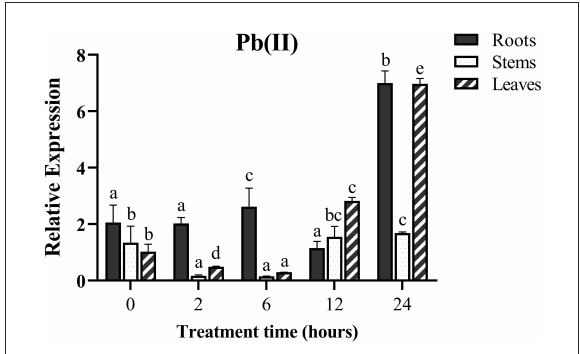
FIGURE2 Expression of MePMEI1 under Pb stress. The 45-days-old SC8 cassava seedlings were treated with 1mM Pb(NO 3 ) 2 for 0, 2, 6, 12, and 24h, following which the root, stem, and leaf samples were collected for RT-qPCR analysis. Tubulin was used as the reference gene. The data are presented as the mean ± SEM of observations from three biological replicates. The significant differences in MePMEI1 expression in the tissues were analyzed at different time points. The different letters indicate significant differences at the 0.05 level (Duncan